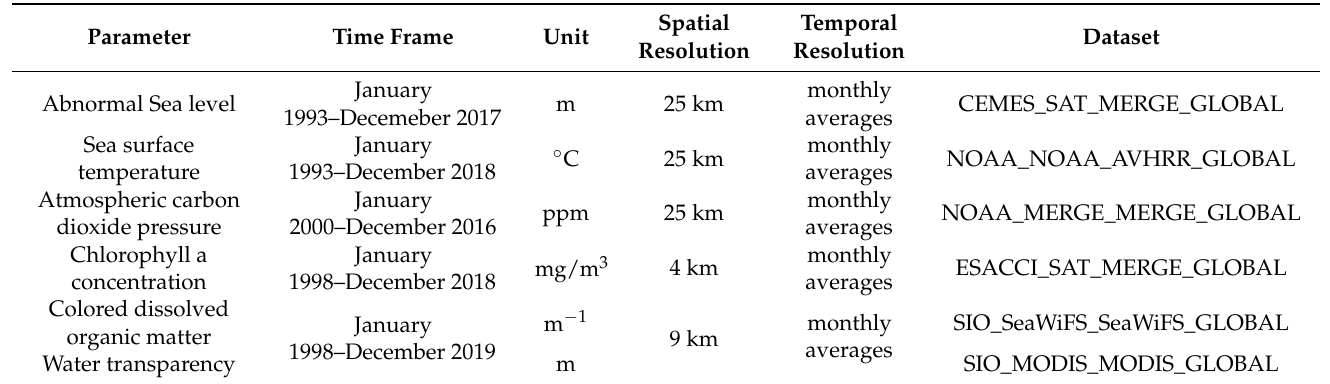
Table 1. Detailed information table of water environment